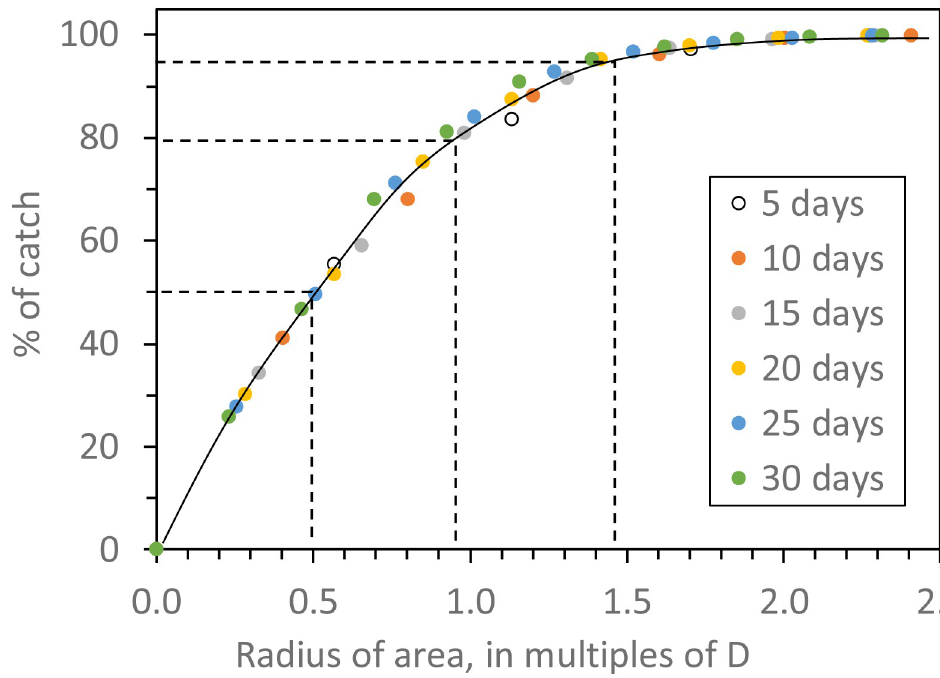
Fig 5. Percentage of the catch originating from areas of various radii around a single trap after different numbers of days of trapping. The radii are expressed as multiples of the mean distance D between the start and end points of the flies’ movements during the whole duration of various trapping periods, from 5–30 days. Data are extracted from the studies of Fig 4, in which the natural daily death rate, Mnat , was 0.03, and the daily death rate due to control, Mcon , was zero, and the catching efficiency, E , was